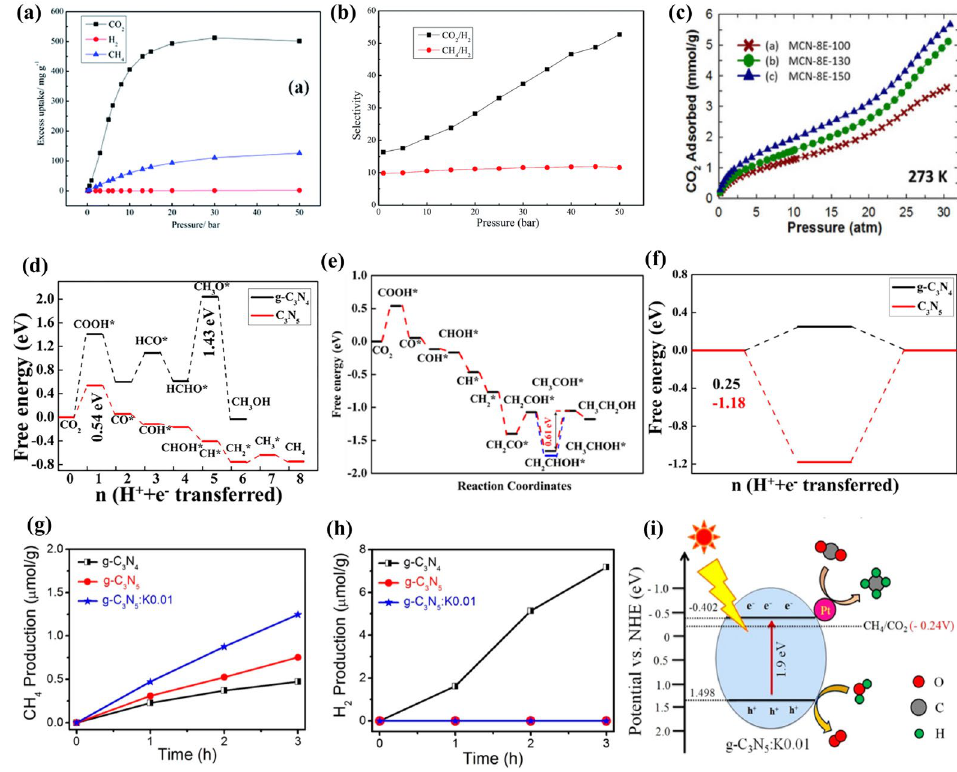
Figure 16. Adsorption and conversions of CO 2 : ( a ) Adsorption performance; ( b ) Adsorption selectiv- ity for the binary mixtures CO 2 /H 2 (20/80) and CH 4 /H 2 (50/50); ( c ) CO 2 adsorption on MCN-8E-T; ( d ) and ( e ) Calculated free energy diagram corresponding to the optimal path of the CO 2 conversion to CH 4 and CH 3 CH 2 OH on the g-C 3 N 5 , respectively; ( f ) Free energy diagram of HER (side reaction) on the g-C 3 N 5 ; ( g ) and ( h ) CH 4 and H 2 evolution rate in photocatalytic CO 2 reduction by g-C 3 N 5 : K0.01, respectively; ( i ) Schematic representation of the photocatalytic CO 2 reduction using g-C 3 N 5 : K0.01. ( a − b ) Adapted with permission from [29]. Copyright Royal Society of Chemistry, 2018. ( c ) Adapted with permission from [19]. Copyright Wiley-VCH Verlag GmbH and Co. KGaA, Weinheim, 2017. ( d − f ) Adapted with permission from [69]. Copyright Elsevier Inc, 2020. ( g − i ) Adapted with permission from [35]. Copyright American Chemical Society, 2022.